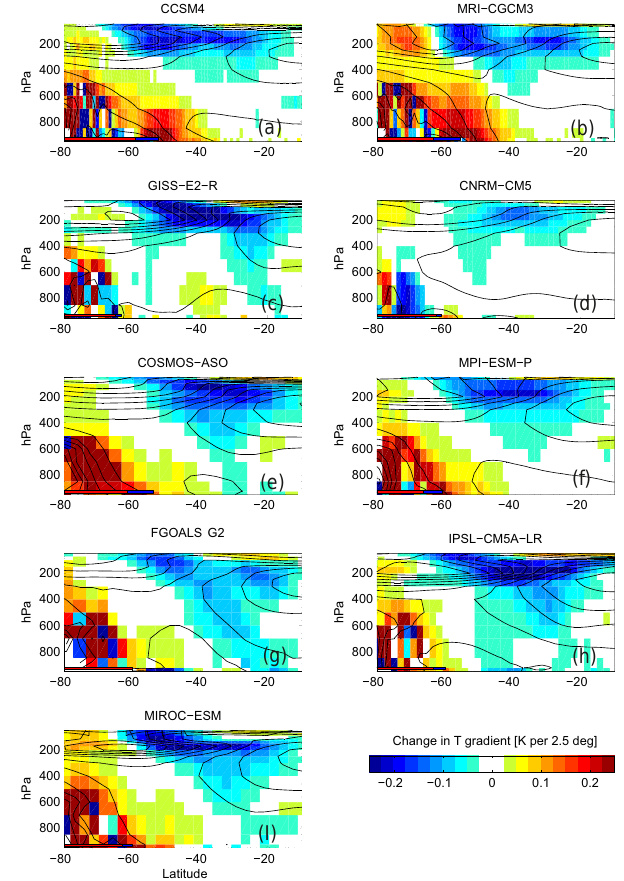
Figure 6. Change is zonal mean temperature gradient (LGM − PI) throughout the atmosphere (shaded). Black contours show the mean temperature gradient for the PI. All temperature gradients are meridional. Red and blue bars at the bottom left of each panel indi- cate the extent of the zonal mean sea ice for the Pi and LGM, respec- tively. Individual panels are labelled to indicate individual models. All values are annual